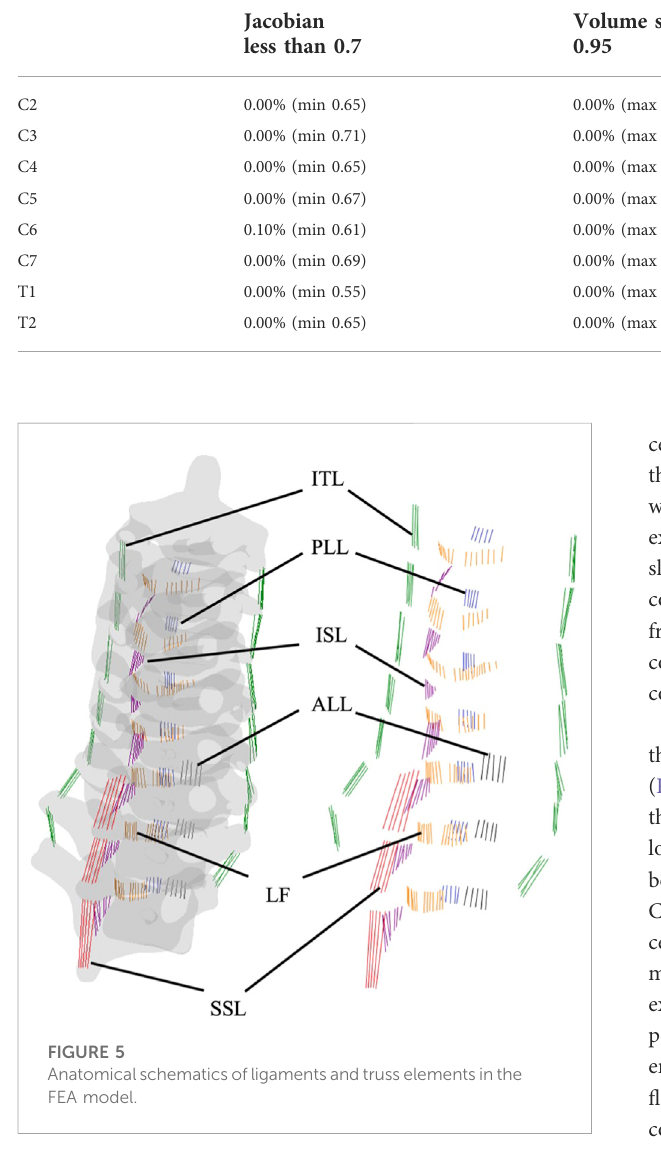
TABLE 3 Mesh quality inspection criterion and the percentage of fair-quality element.